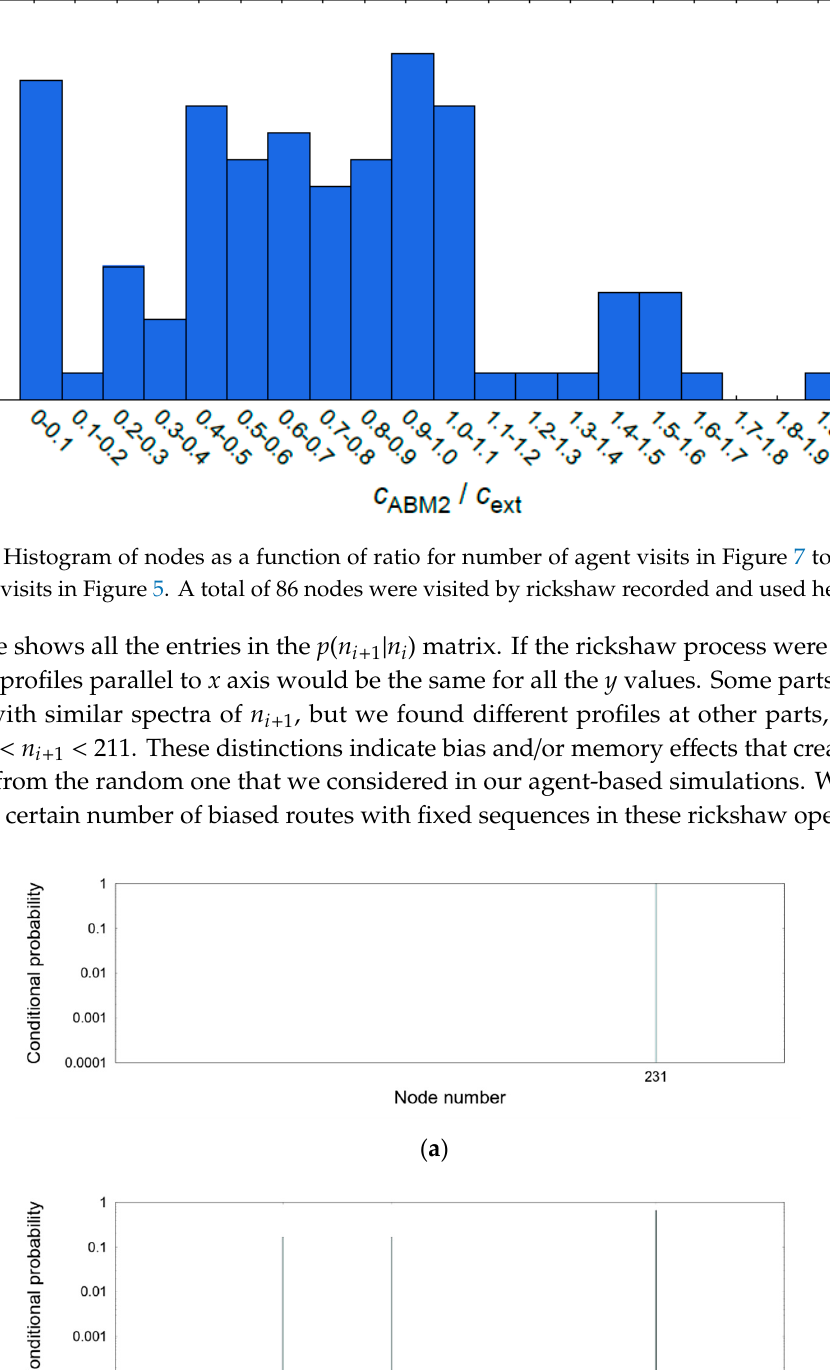
Figure 7. Distributions of agent visits based on agent-model simulations. Agents are mobile in a network with 86 nodes with 594 directed edges (not shown), configured with conditioning probabilities derived from datasets of real rickshaws on the cloud server. We removed two nodes since the counts at these two points have more values than the others: node 11 (counts = 179) and node 231 (counts = 3196).